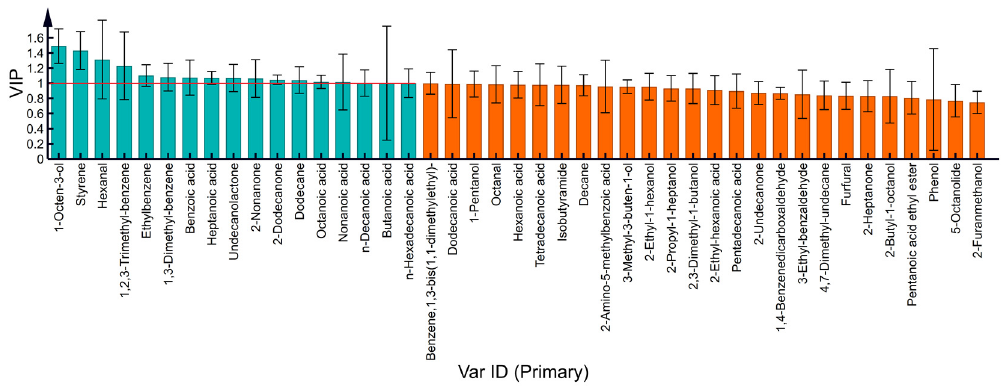
Figure 6. VIP chart of milk VOCs at different processing temperatures.